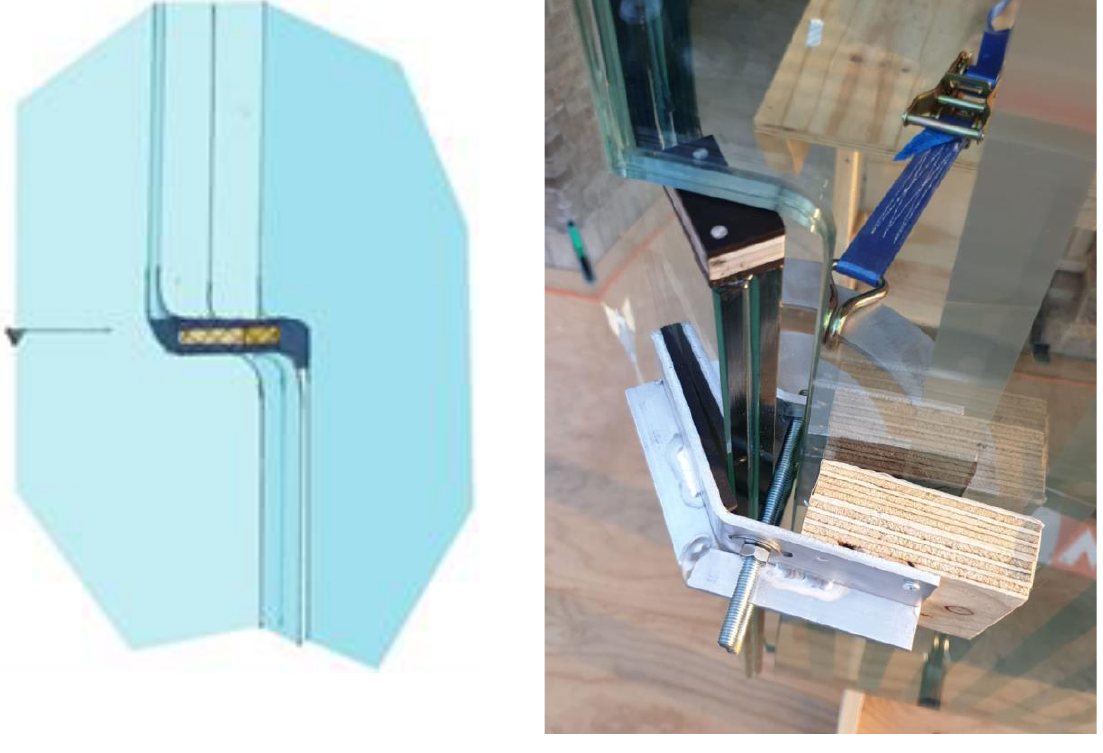
Fig. 8 3D sketch of the skewed notches. Fig. 9 test assembly of the skewed